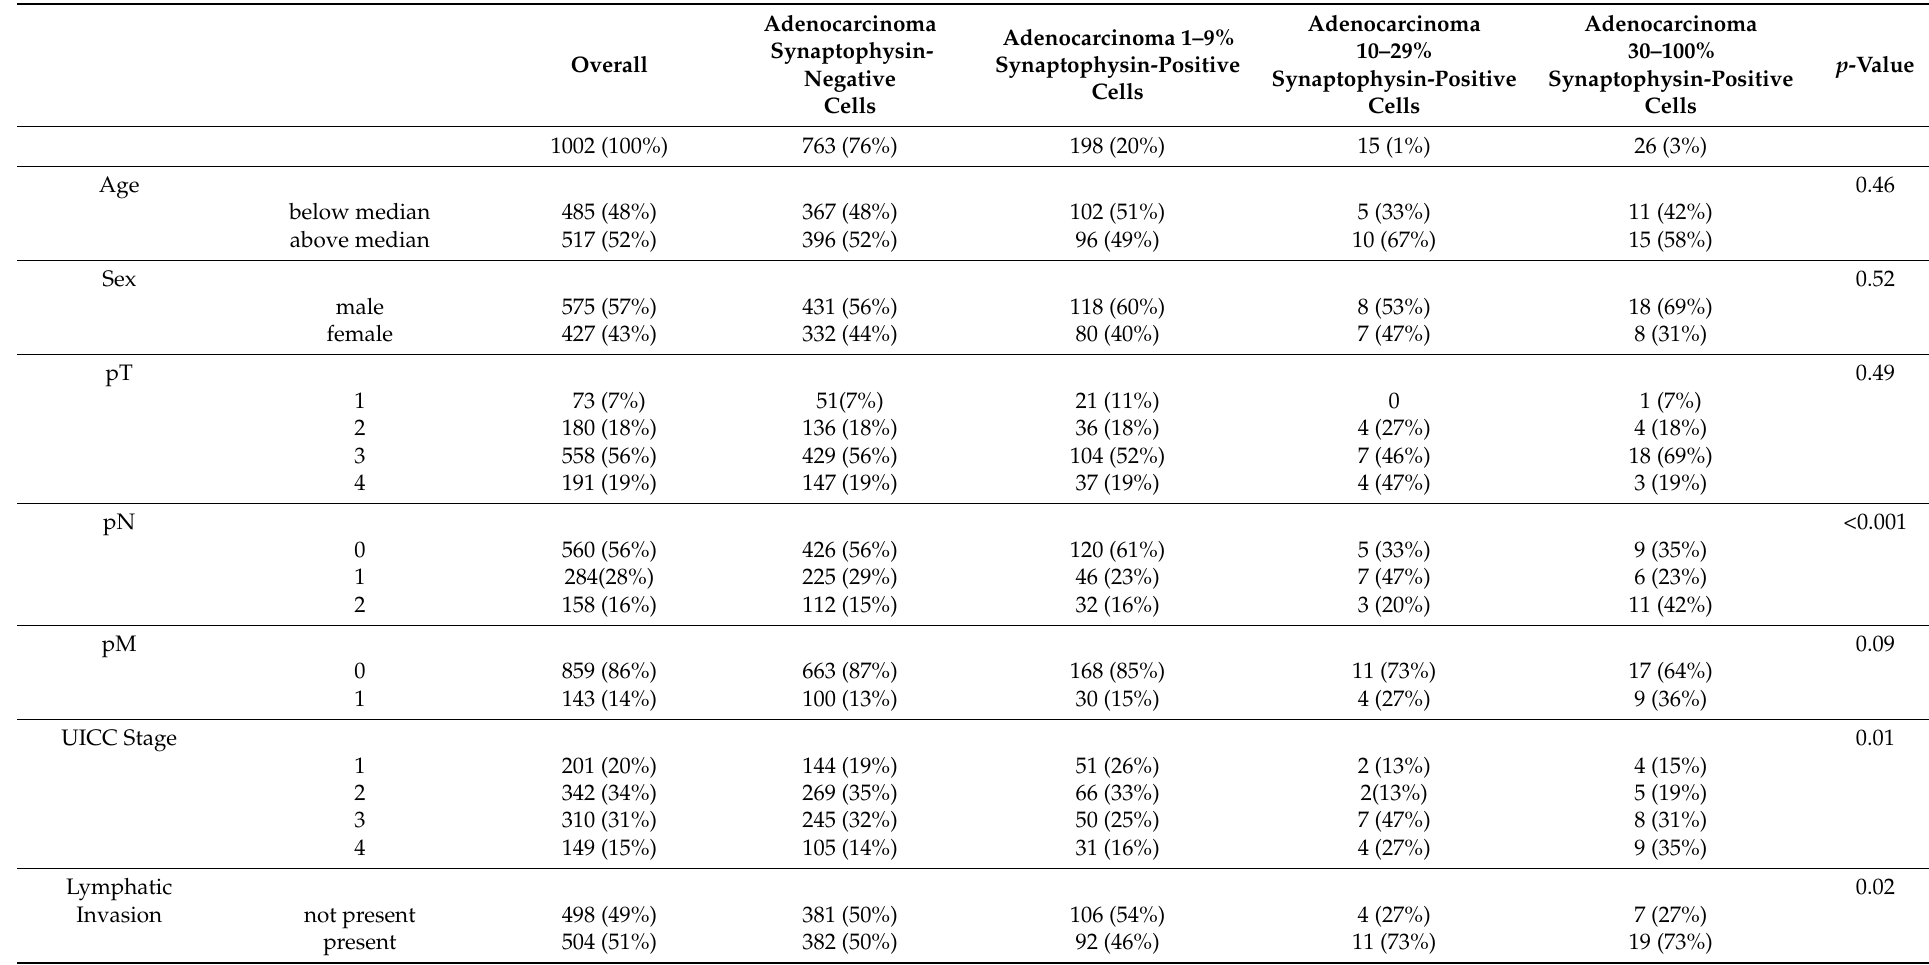
Table 1. Distribution and statistical associations to clinicopathological characteristics of synaptophysin expression groups in conventional adenocarcinomas with a non-neuroendocrine